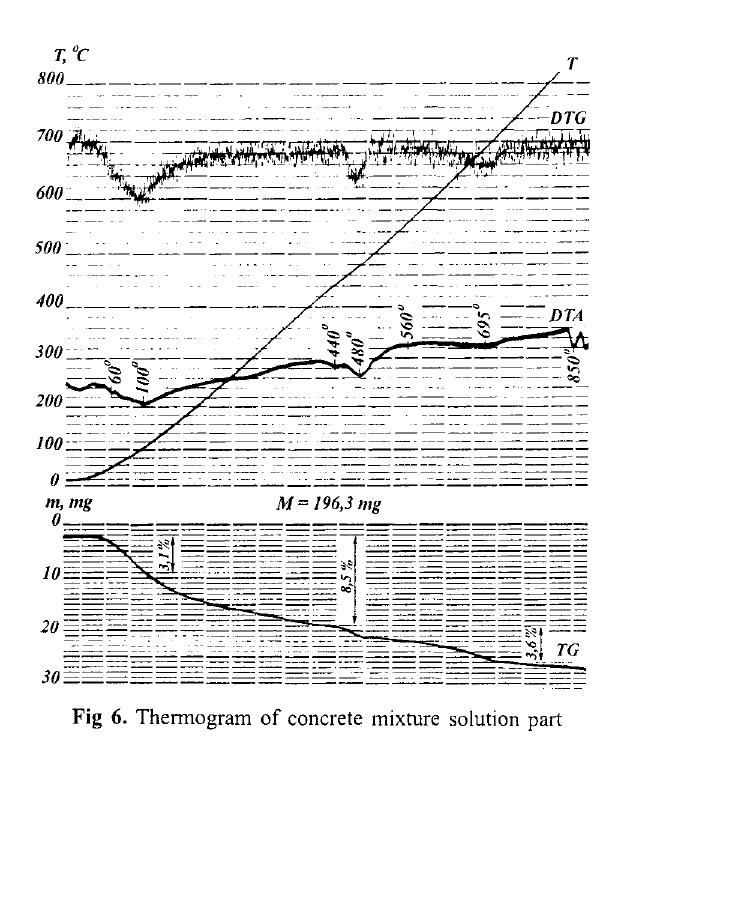
Fig 6. Thermogram of concrete mixture solution